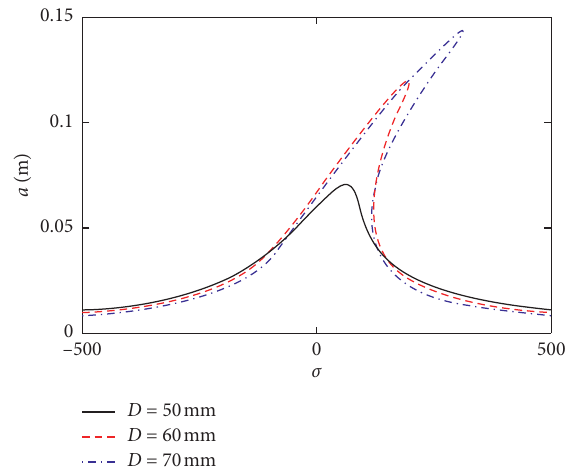
Figure 11: Effect of the diameter of the cutting bar on primary resonance curves.